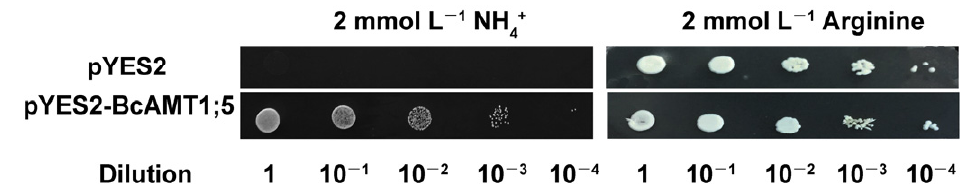
Figure 3. Functional complementation of BcAMT1;5 in yeast mutant 31019b cells. The optical density of yeast cell suspensions was adapted to 1.0 at 600 nm (dilution 1). After serial dilution by factors of 10, 3 μ L of the yeast cell suspension each dilution was spotted on the yeast nitrogen base medium. A three-day incubation of yeast cells at 30 °C was evaluated and photographed.